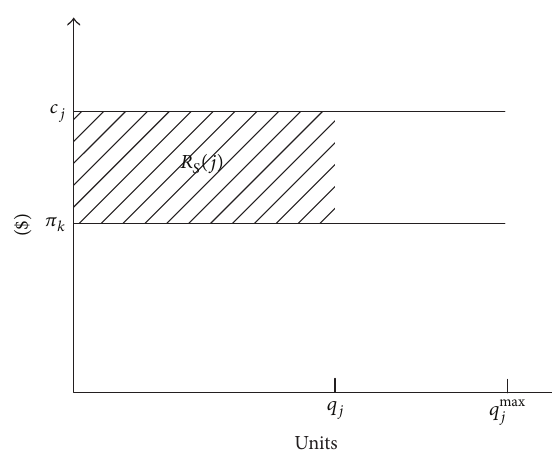
Figure 2: Cost 𝑅 𝑆 (𝑗) of forced sell. Figure 3: Loss of profits